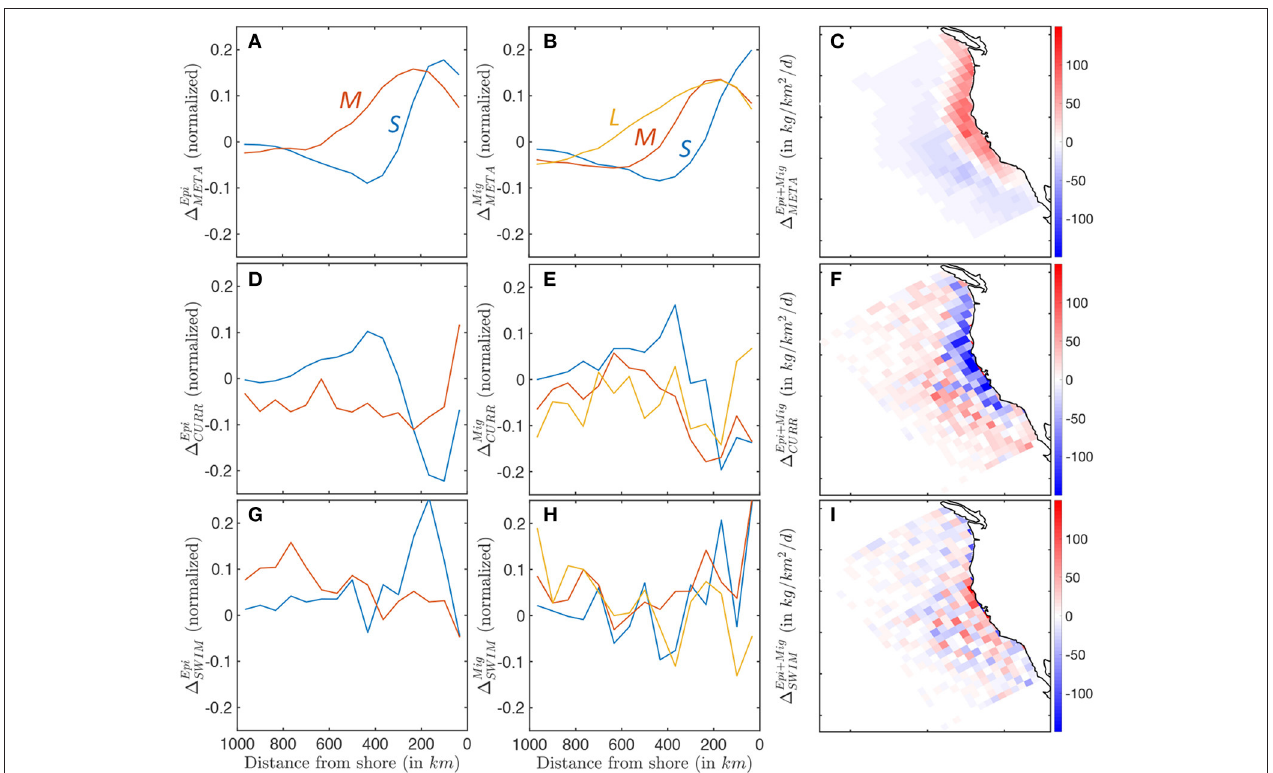
FIGURE 10 | Biomass accumulation and dissipation along a cross-shore section, for small (blue), medium (red), and large (yellow) fish, reflecting food-web dynamics and spatial transport processes. (A–C) Surplus production for pelagic and migratory communities 1 META . (D–F) Accumulation and dissipation due to passive advection by currents for pelagic and migratory communities 1 CURR . (G–I) Accumulation and dissipation due to active swimming for pelagic and migratory communities 1 SWIM . The maps show averages binned in 1 x = 96km grid cells to smooth spatial variability caused by mesoscale